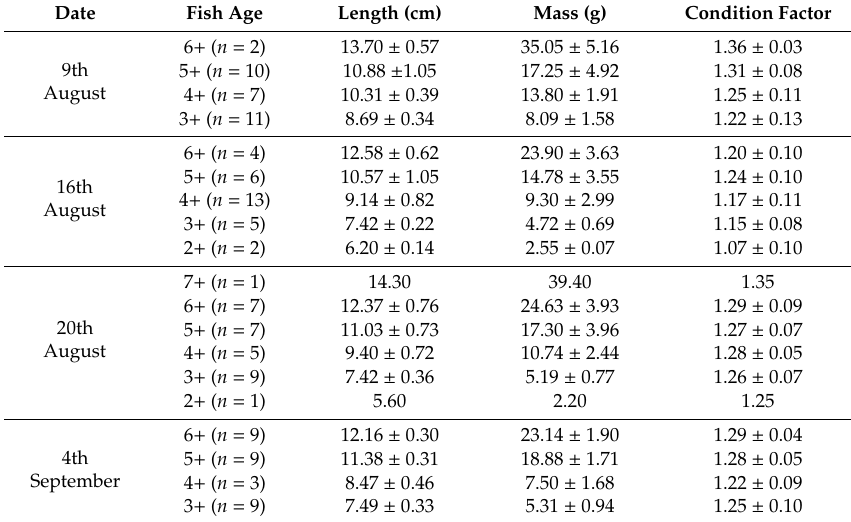
Table 1. Mean values ± SD of total length, mass and condition factor of